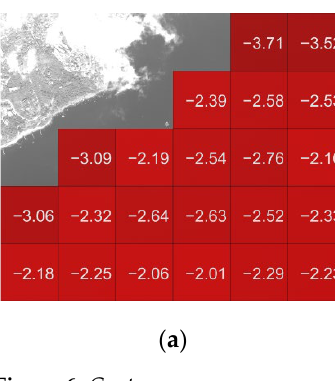
Figure 5. One-dimensional spectra for fragments of different sizes near the platform. For greater clarity, the horizontal axis has two types of labels: frequency and wavelength. Vertical and horizontal axes have a logarithmic scale.